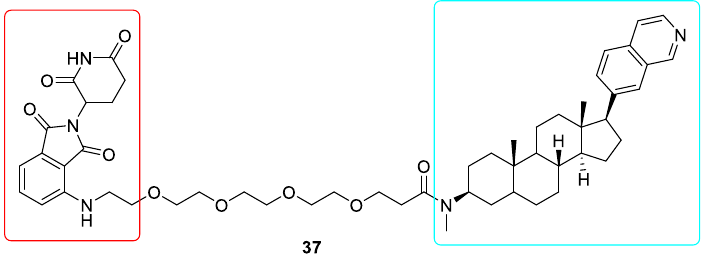
Figure 10. Chemical structure of CDK8 PROTAC. Red rectangle denotes the pomalidomide moiety, light blue rectangle denotes the Cortistatin A derivative JH-VIII-49 moiety.